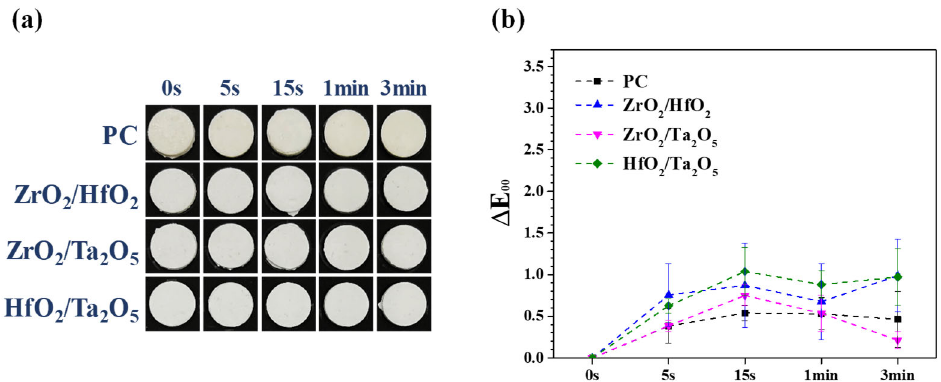
Figure 8. ( a ) Photos and ( b ) corresponding ∆ E 00 values for MTA-like cements prepared using as-milled binary oxide powder and irradiated under UV exposure.